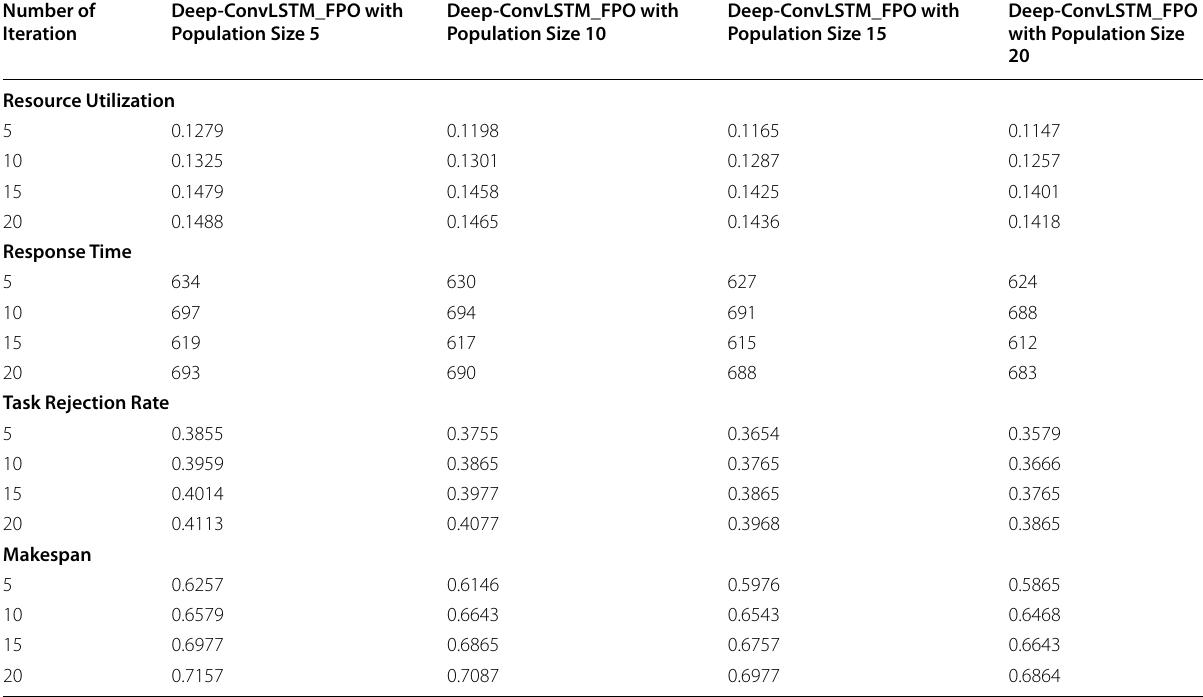
Table 5 Performance Assessment of Deep-ConvLSTM_FPO with Task Size 400 Number of